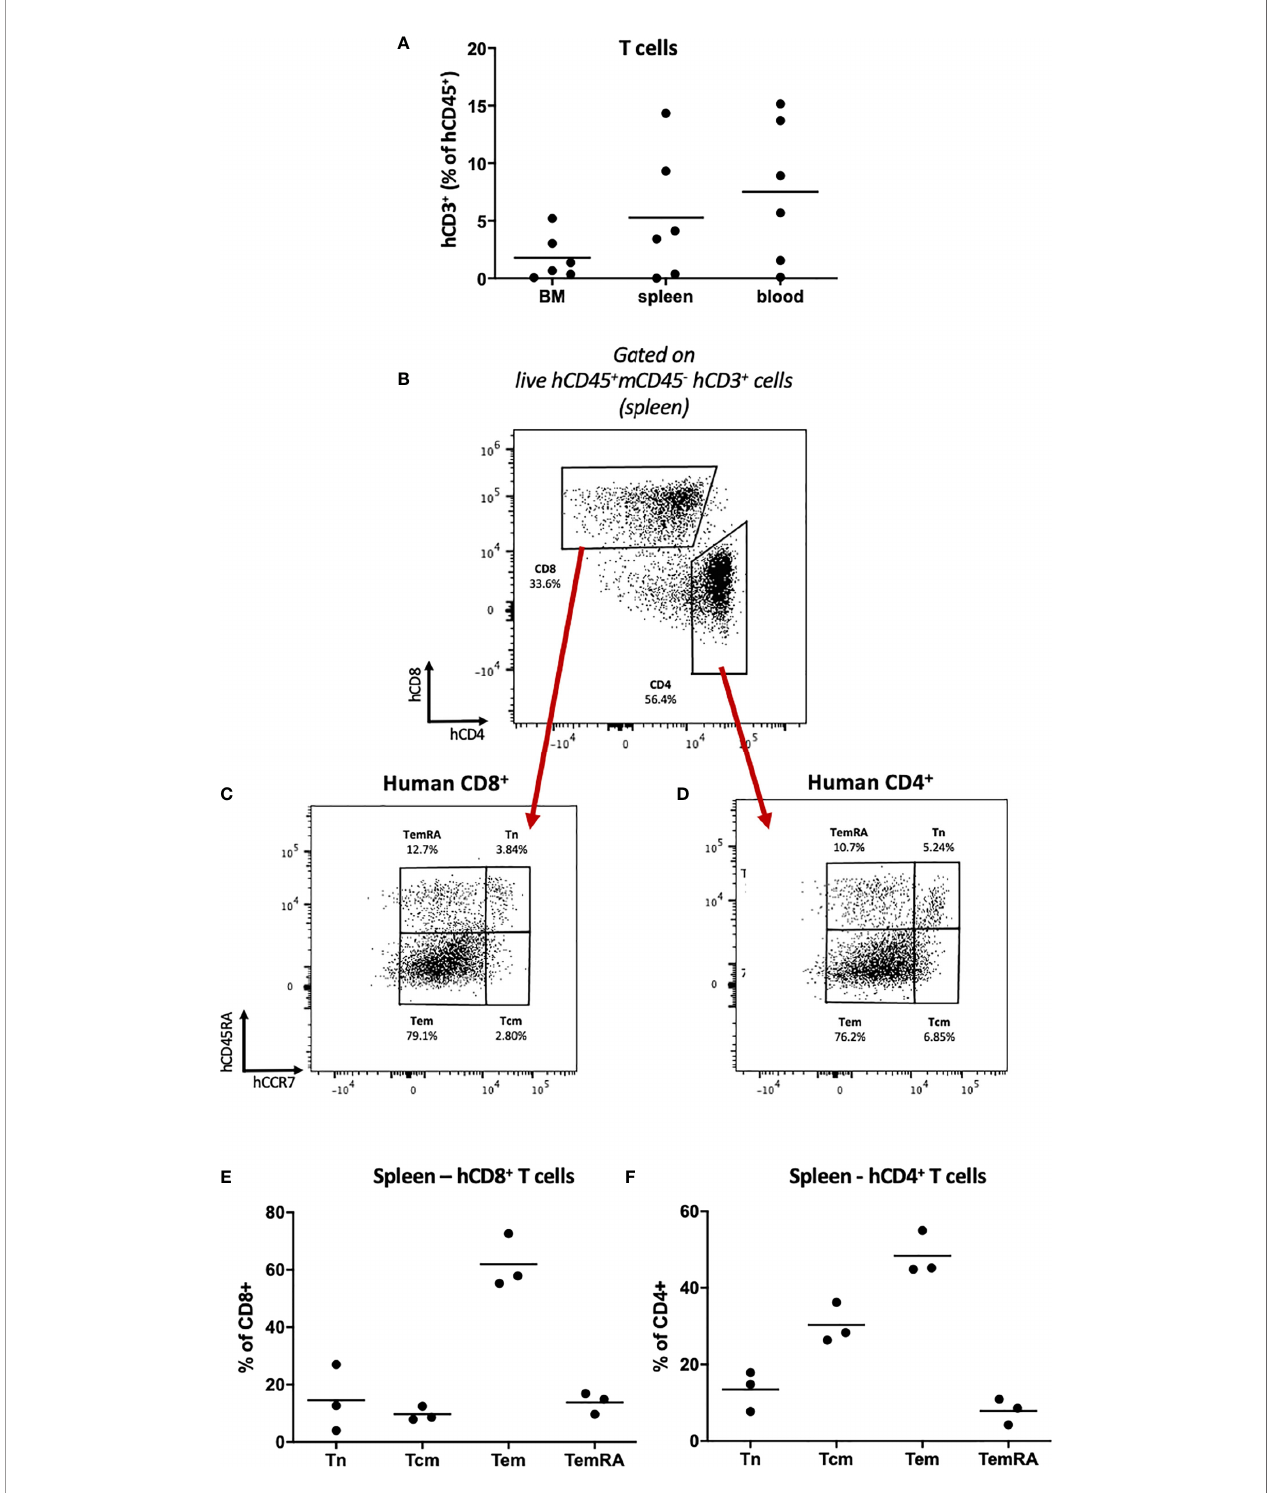
FIGURE 4 | Human T cell repopulation in HSPC-NBSGW mice (A) Frequencies of human CD3 + T cells in the bone marrow, spleen and blood of HSPC-NBSGW mice 20-22 weeks after cell injection, as determined by fl ow cytometry (50x10 3 HSPC dose shown). (B – D) Representative fl ow cytometric analysis of (B) CD4 and CD8 expression on live human CD45 + CD3 + splenic T cells, (C) CD8 + and (D) CD4 + T cell subsets, determined by surface expression of CD45RA and CCR7. (E, F) Frequencies of CD8 + (D) and CD4 + (E) splenic T cell subsets: naïve (Tn; hCD45RA + hCCR7 + ), Tcm (hCD45RA - hCCR7 + ), Tem (hCD45RA - hCCR7 - ) and TemRA (hCD45RA + hCCR7 - ) (250x10 3 HSPC dose shown). Bars indicate median